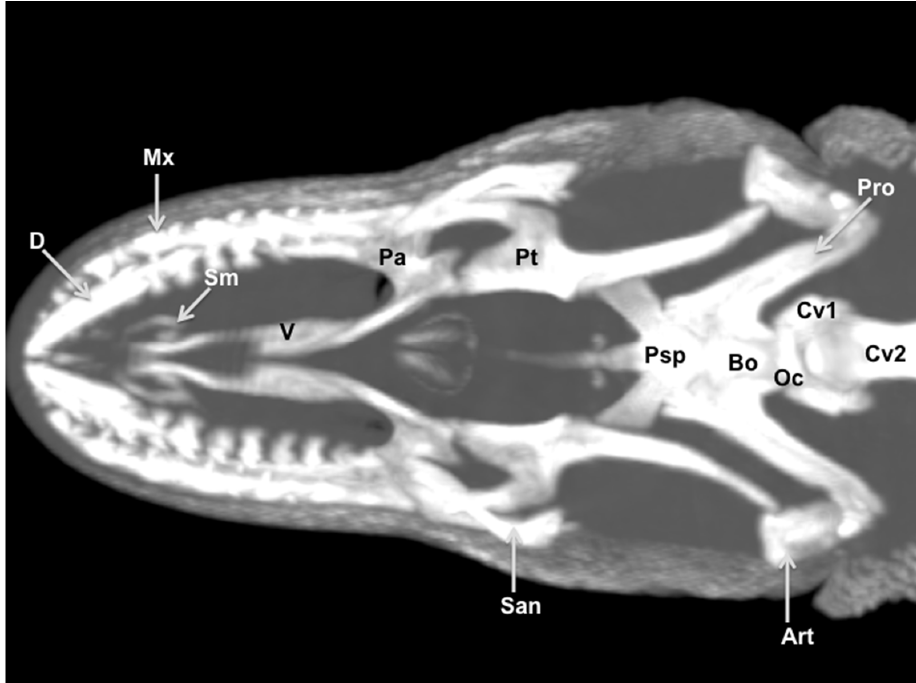
Figure 11. Ventral MIP image of the cranium of Varanus komodoensis . D: Dentary bone. Mx: Maxillary bone. San: Surangular bone. Art: Articular bone. Bo. Basioccipital bone. Psp: Parabasisphenoid bone. Oc: Occipital condyle. Pro: Prootic bone. Sm: Septomaxilla. V: Vomer. Pa: Palatine bone. Pt: Pterygoid bone. Cv1: First cervical vertebra. Cv2: Second cervical vertebra.